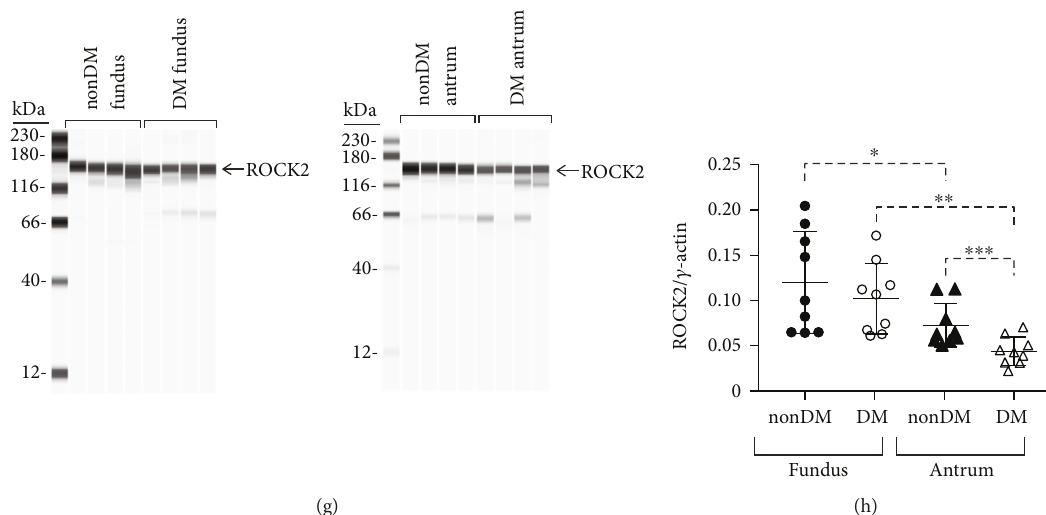
Figure 2: Protein expression levels in nondiabetic and diabetic gastric fundus and antrum smooth muscles. Representative immunoblots of (a) enteric γ -actin, 250ng muscle lysate/lane, (c) MYLK, 1 μ g muscle lysate/lane, (e) PP1 δ , 2.5 μ g muscle lysate/lane, and (g) ROCK2, 2.5 μ g muscle lysate/lane, expression in nondiabetic and diabetic fundus (left panel, n = 4 , each group) and nondiabetic and diabetic antrum muscles (right panel, n = 4 , each group). (b) Enteric γ -actin expression per g of nondiabetic and diabetic fundus and antrum muscles. (d) Smooth muscle MYLK expression relative to enteric γ -actin expression in nondiabetic and diabetic fundus and antrum smooth muscles. (f) PP1 δ expression relative to enteric γ -actin expression in nondiabetic and diabetic fundus and antrum smooth muscles. (h) ROCK2 expression relative to enteric γ -actin expression in nondiabetic and diabetic fundus and antrum smooth muscles. ∗ P < 0 05 , ∗∗ P < 0 01 , and ∗∗∗ P < 0 0001